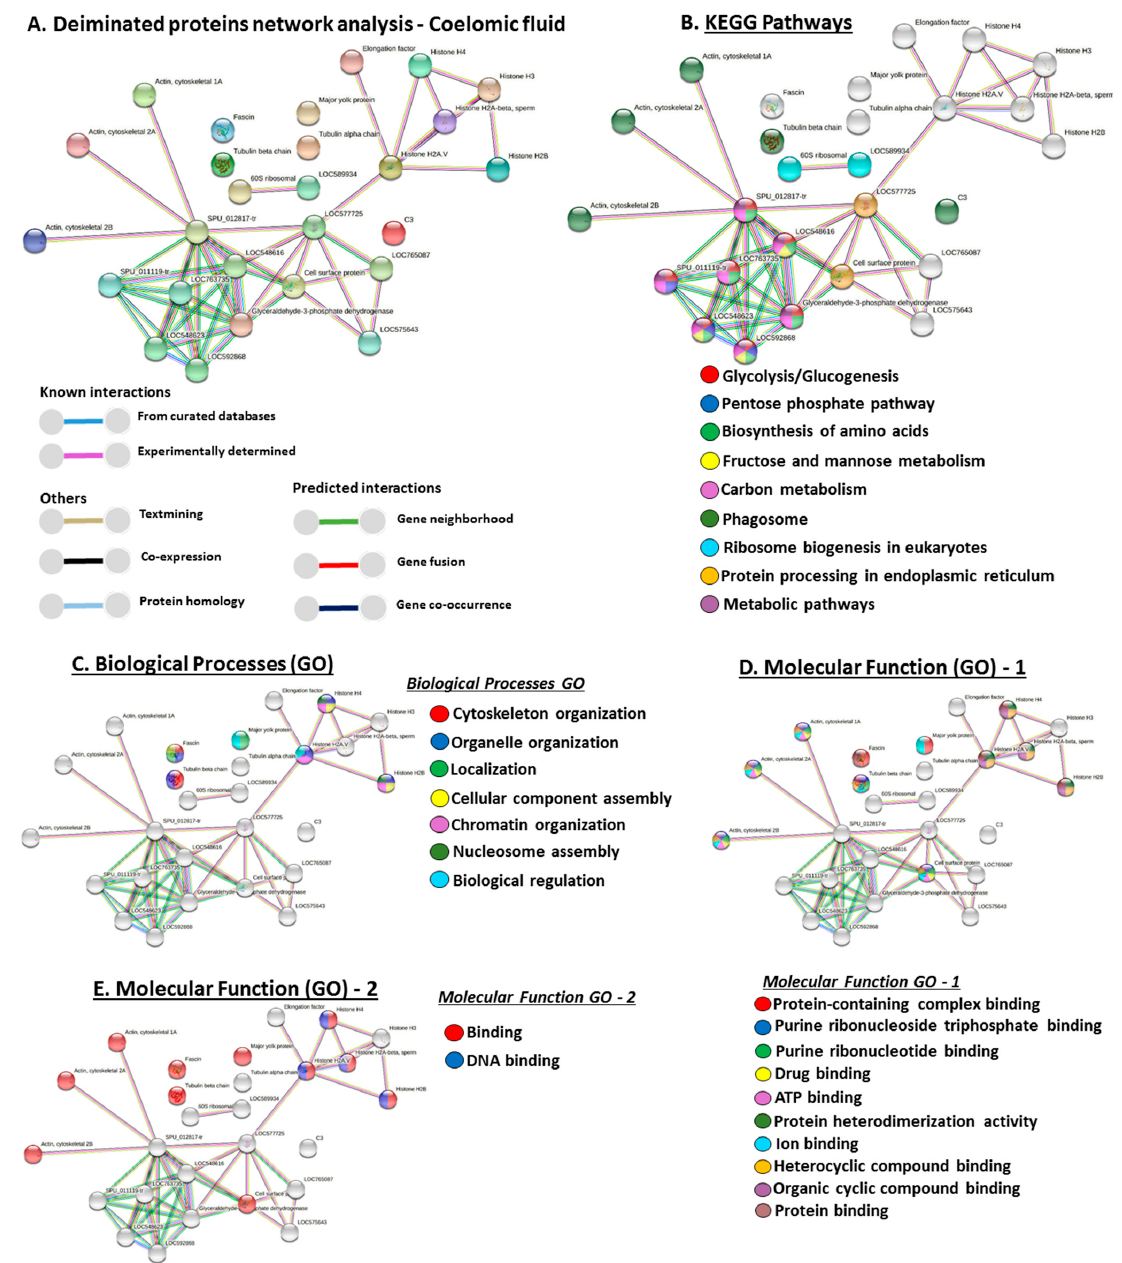
Figure 5. Protein–protein interaction networks of deiminated proteins identified in purple sea urchin coelomic fluid. ( A ) Protein networks for deiminated proteins in purple sea urchin coelomic fluid based on known and predicted interactions in Echinoidea, using STRING analysis. Coloured nodes represent query proteins only. Coloured lines connecting nodes show the type of interactions between the nodes of the networks based on known interactions, predicted interactions, and others (including text-mining, co-expression, and protein homologue); colour code legend is provided in the figure. PPI enrichment p -value for the protein network is 5.31 × 10 − 5 . ( B ) KEGG pathways identified from STRING analysis for the deiminated protein candidates in purple sea urchin coelomic fluid. ( C ) Gene Ontology (GO) Biological processes identified from STRING analysis for deiminated protein candidates in purple sea urchin coelomic fluid. ( D , E ) GO Molecular functions identified from STRING analysis for deiminated proteins candidates in purple sea urchin coelomic fluid. Protein names of hits listed in the tables are presented in the figures; additional interacting proteins are: LOC589934 = large subunit GTPase 1 homolog; LOC577725 = heat shock protein 83; LOC765087 = Hsp70/Hsp90-organising protein; LOC575643 = activator of heat shock 90kDa protein ATPase homolog 1; LOC763735 = Pyruvate kinase; LOC548623 = Fructose-bisphosphate aldolase; LOC592868 = Fructose-bisphosphate aldolase, non-muscle type like; SPU_012817-tr = Phosphoglycerate kinase; SPU_011119-tr = Glucose-6-phosphate